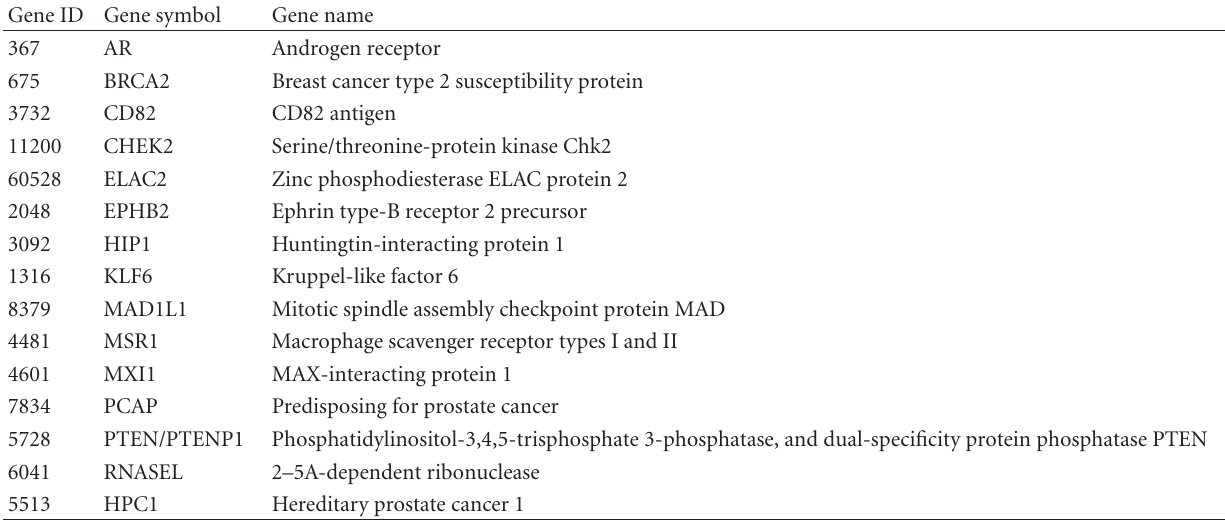
Table 1: Seed genes of prostate cancer from omim database.